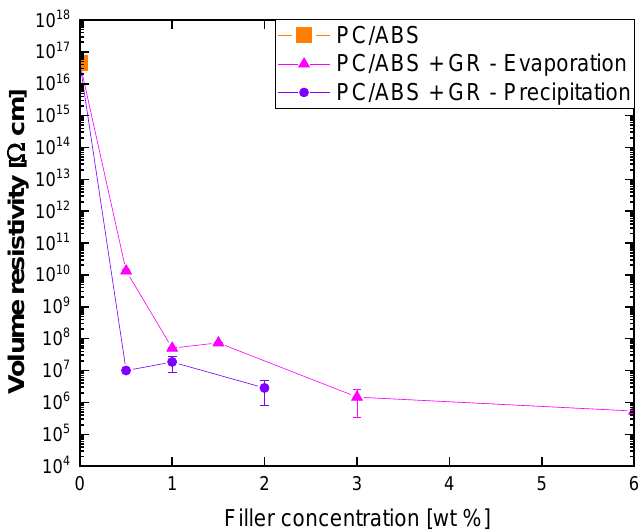
Figure 2. Variation of electrical resistivity with graphene (GR) concentration in PC / ABS composites prepared by solution mixing.